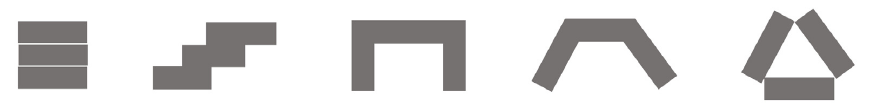
Figure 7. The different types of building arrangements.